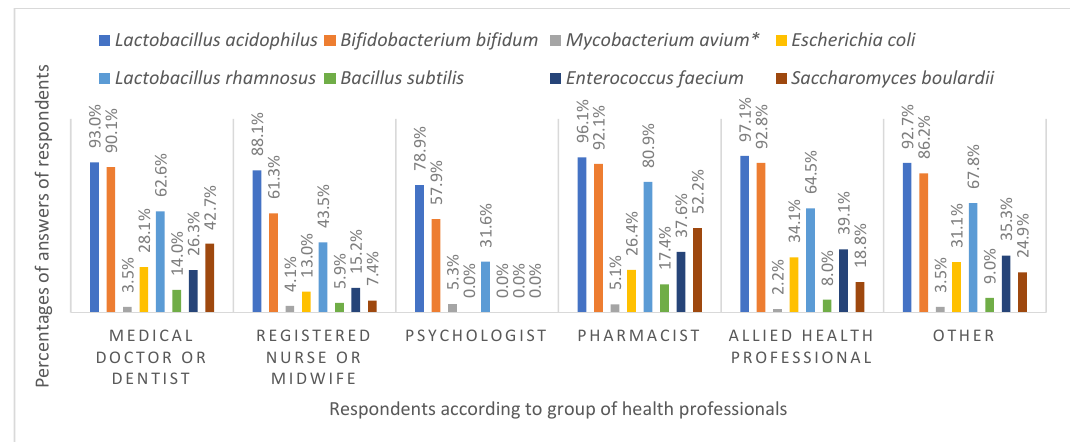
Figure 4. Respondents’ knowledge of microbial species with possible probiotic strains according to health profession. * This species has no probiotic strains.